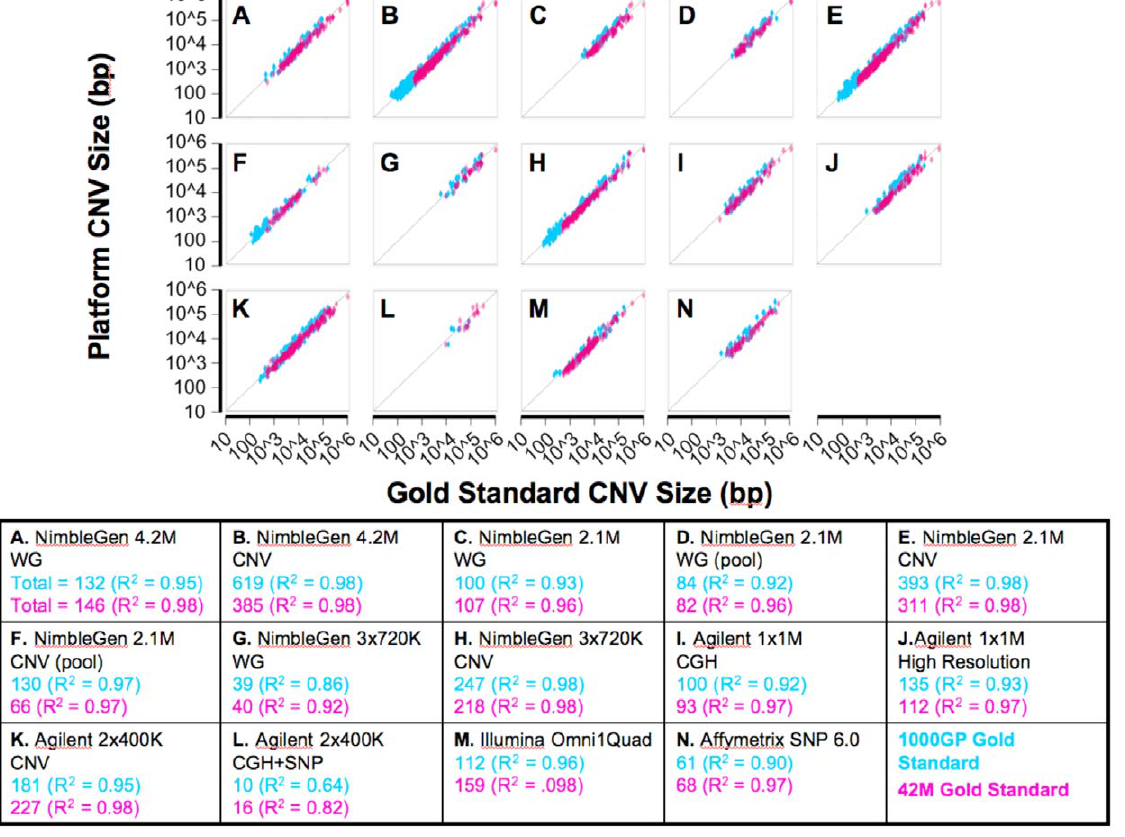
Figure 3. Resolution of array platform CNV calls for known Gold Standard CNVs. Each data point plots the size of a platform CNV versus the size of the corresponding Gold Standard CNV that individually overlaps the platform call by 50% reciprocally. Events overlapping the 1000GP GS CNVs are shown in blue. Events overlapping the 42 M GS CNVs are shown in pink. Total numbers of data points and R 2 values are indicated in the table below. Data is an aggregate of all events from two technical replicates for each platform except the Affymetrix SNP 6.0. The size distribution and total number of platform CNVs that overlap Gold Standard CNVs in this way are also clearly visible. doi:10.1371/journal.pone.0027859.g003 PLoS ONE |